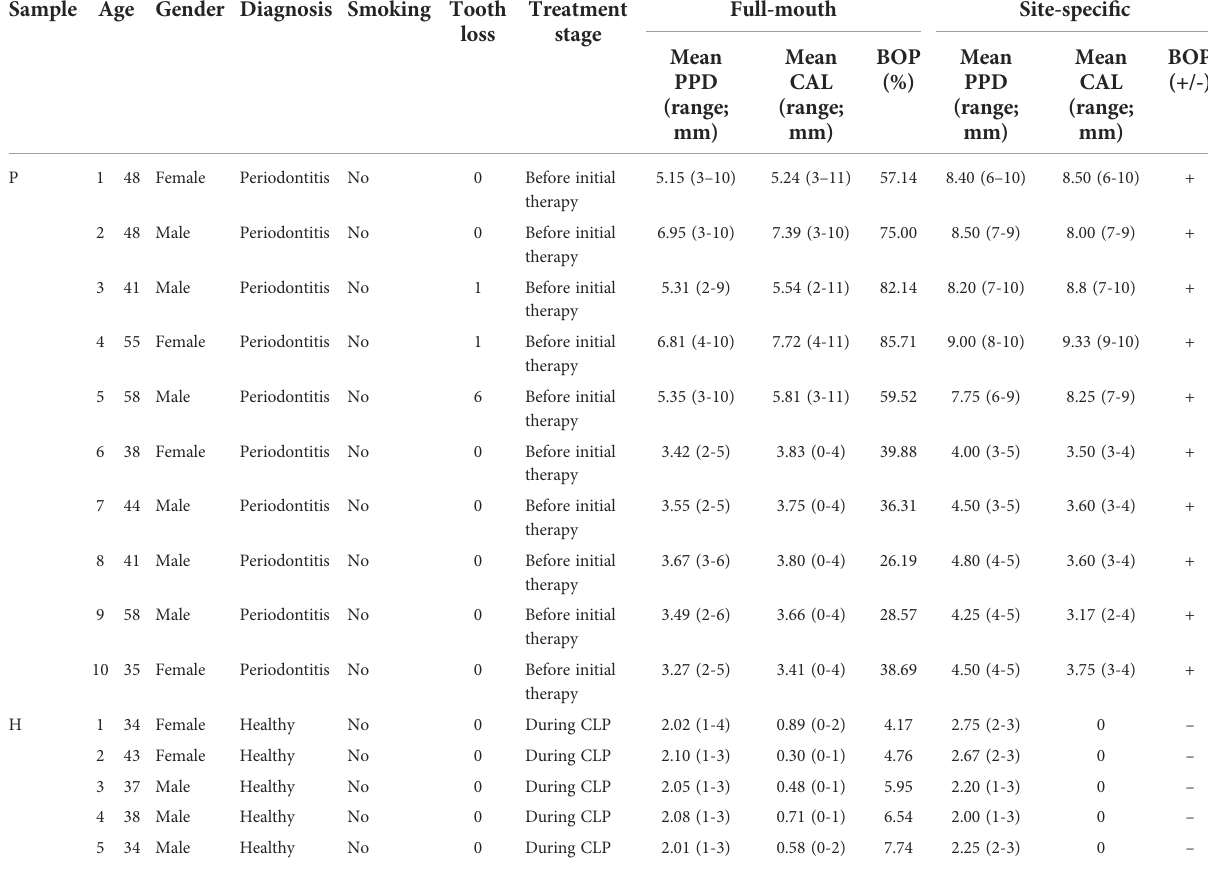
TABLE 1 The basic information of the 15 individuals included in proteomic analysis. Sample Age Gender Diagnosis Smoking